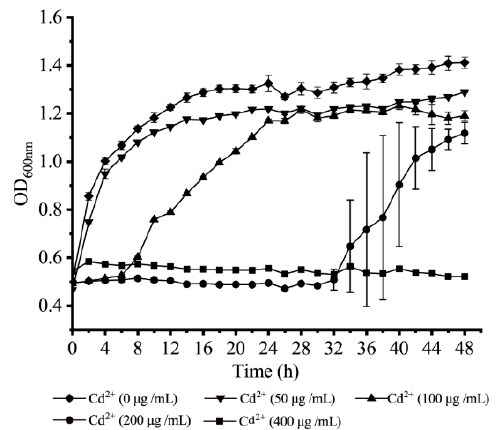
Figure 5. The survival of V. parahaemolyticus N10-18 under different concentrations of heavy metal Cd 2+ . Three replicates were assessed at each concentration.